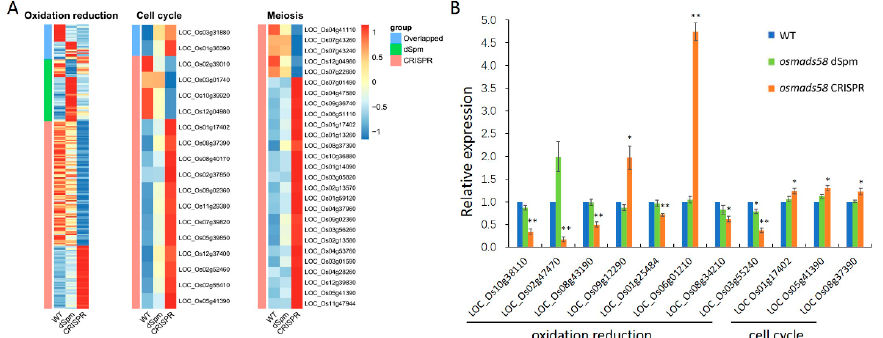
Figure 7. Expression patterns of genes in key pathways and selected genes expression levels verification by RT ‐ qPCR. ( A ) Heatmaps of the expression levels of genes (rows) across conditions (columns). Only the differentially expressed genes are shown. Expression levels are averaged in each condition, followed by scaling in each row. The side color bars indicate whether the genes are dif ‐ ferentially expressed in both two conditions or specifically differentially expressed in only one condition. ( B ) RT ‐ qPCR analysis of expression levels of genes involved in oxidation reduction and cell cycle. Error bars indicate SD of three biological replicates. Student’s paired t ‐ test: * p < 0.05, ** p < 0.01.